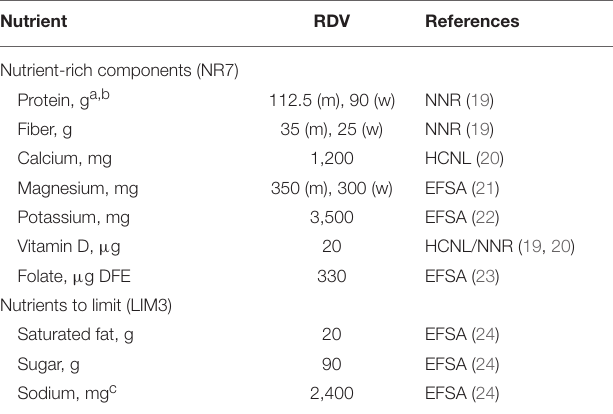
TABLE 1 | Dietary reference values for selected nutrients used in calculating the E-NRF7.3. Nutrient